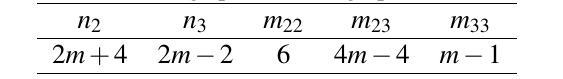
Table 2 Vertex and edge partitions of graphene sheet for n = 1